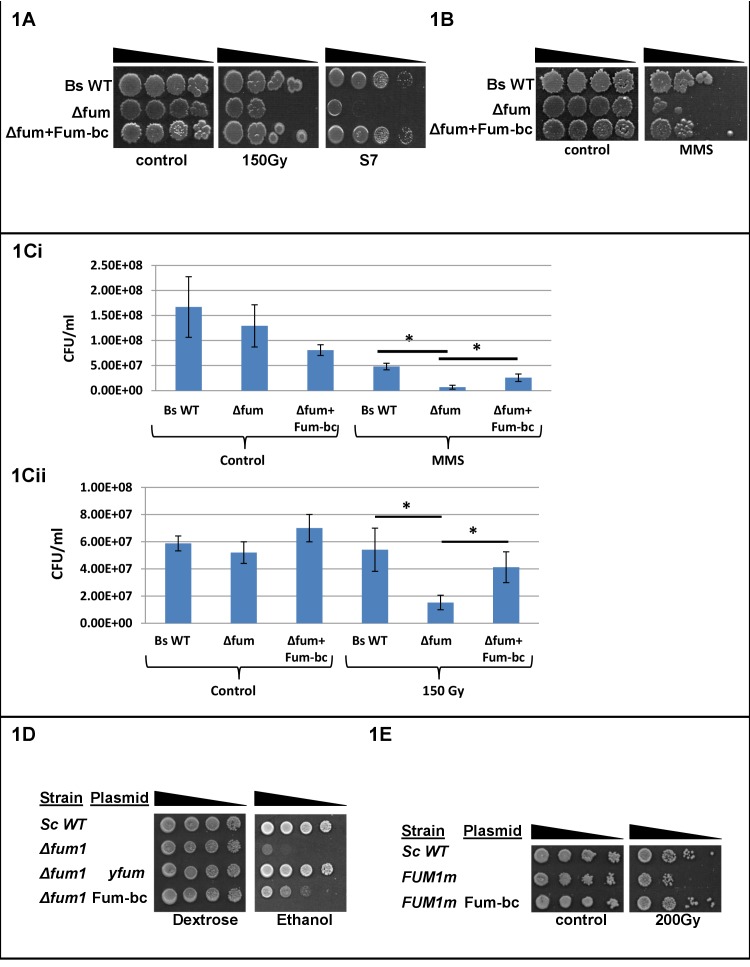
Fumarase is required for an efficient DNA damage response in Bacillus subtilis.(A) Bacillus subtilis wild type (Bs WT) and Δfum (=ΔcitG) strains were untreated (control) or exposed to ionized radiation (150 Gy) and then serially diluted onto LB plates or minimal S7 medium plates (containing 0.1% glucose). (B) Bacillus subtilis Δfum strain is sensitive to DNA damage. Bacillus subtilis wild type (Bs WT), Δfum and Δfum+fum-bc strains were grown to logarithmic phase and MMS (methyl methanesulfonate) was added to a final concentration of 0.07%(v/v) for 45 min. The cells were then washed and serially diluted onto LB plates. (C) Quantitative analysis of Bacillus subtilis Δfum strain sensitivity to DNA damage. (Ci) MMS: Bacillus subtilis wild type (Bs WT), Δfum and Δfum+fum-bc strains were grown to logarithmic phase and MMS (methyl methanesulfonate) was added to a final concentration of 0.07%(v/v) for 50 min. Colony forming units (CFU) were determined after plating serial dilutions of cell cultures on LB agar plates. (mean ±SEM [n = 3], p=0.01). (Cii) Ionized radiation (IR): Bacillus subtilis wild type (Bs WT) and Δfum strains, grown as above, were untreated (control) or exposed to IR (150 Gy). The CFU was determined as above. (mean ±SEM [n = 3], p=0.04). (D) fum-bc can complement DNA damage sensitivity in yeast. Saccharomyces cerevisiae wild type (Sc WT) and Δfum1 strains harboring the indicated plasmids were serially diluted and grown on glucose (dextrose) or ethanol SD medium plates. (E) fum-bc can complement respiration in yeast. Saccharomyces cerevisiae wild type (Sc WT), FUM1m and FUM1m transformed with a plasmid-encoding Bacillus subtilis fumarase, were grown to logarithmic phase in galactose SD medium, irradiated and serially diluted onto galactose SD plates. The data presented in Figure 1, in each case, represent the results of three similar experiments.